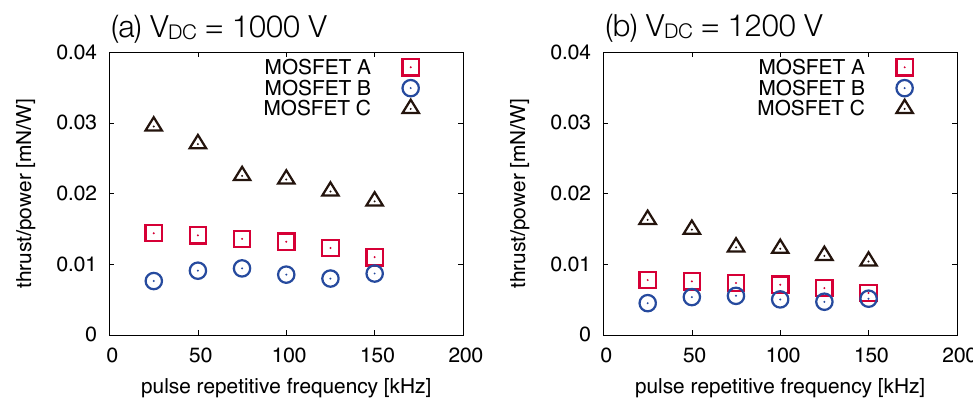
Figure 8. Thrust-to-power ratio of the DBD plasma actuator as a function of repetitive pulse frequency for different SiC-MOSFETs for DC voltages of ( a ) 1000 V and ( b ) 1200